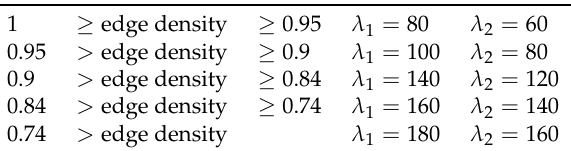
Table 4. Choices of parameters λ 1 and λ 2